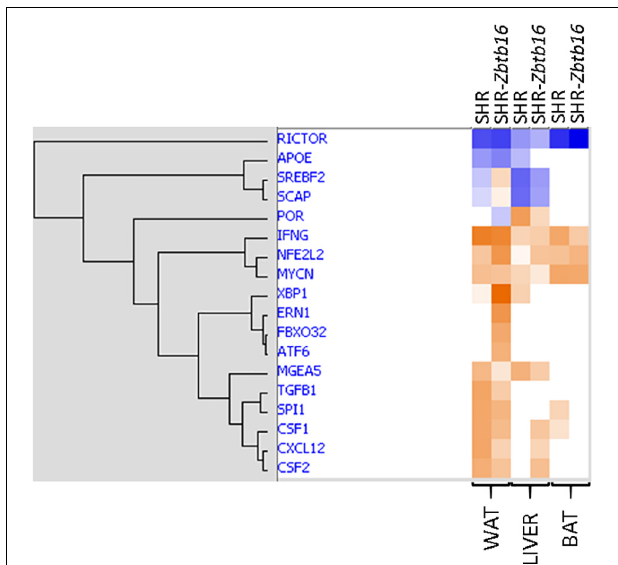
FIGURE 12 | Comparison of maternal HSD programming effect on activation (shades of orange) or inhibition (shades of blue) of upstream regulators in white adipose tissue (WAT), liver and brown adipose tissue (BAT) in male offspring of HSD- vs. standard diet-fed rat dams of SHR and SHR- Zbtb16 rat strains. Hierarchical clustering and calculation of activation z-scores were performed using Ingenuity Pathways Analysis.